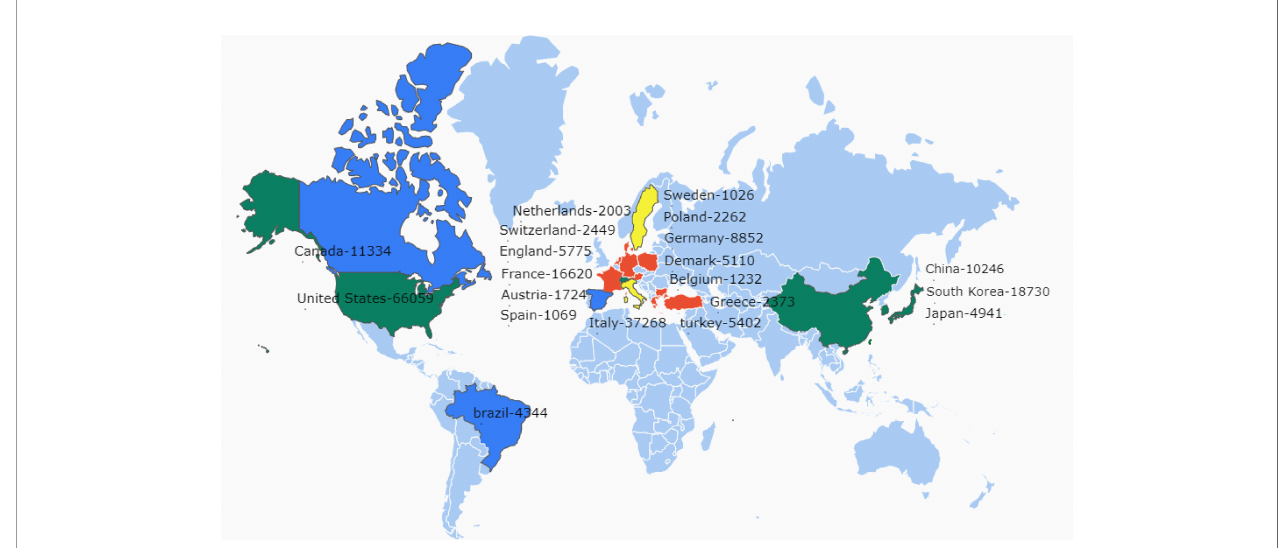
FIGURE 2 | Top 20 countries with the most cited medical publications. Country name and citation number are shown on the map. The countries are sorted into different-coloured clusters and countries with the same colour show strong links by citation or